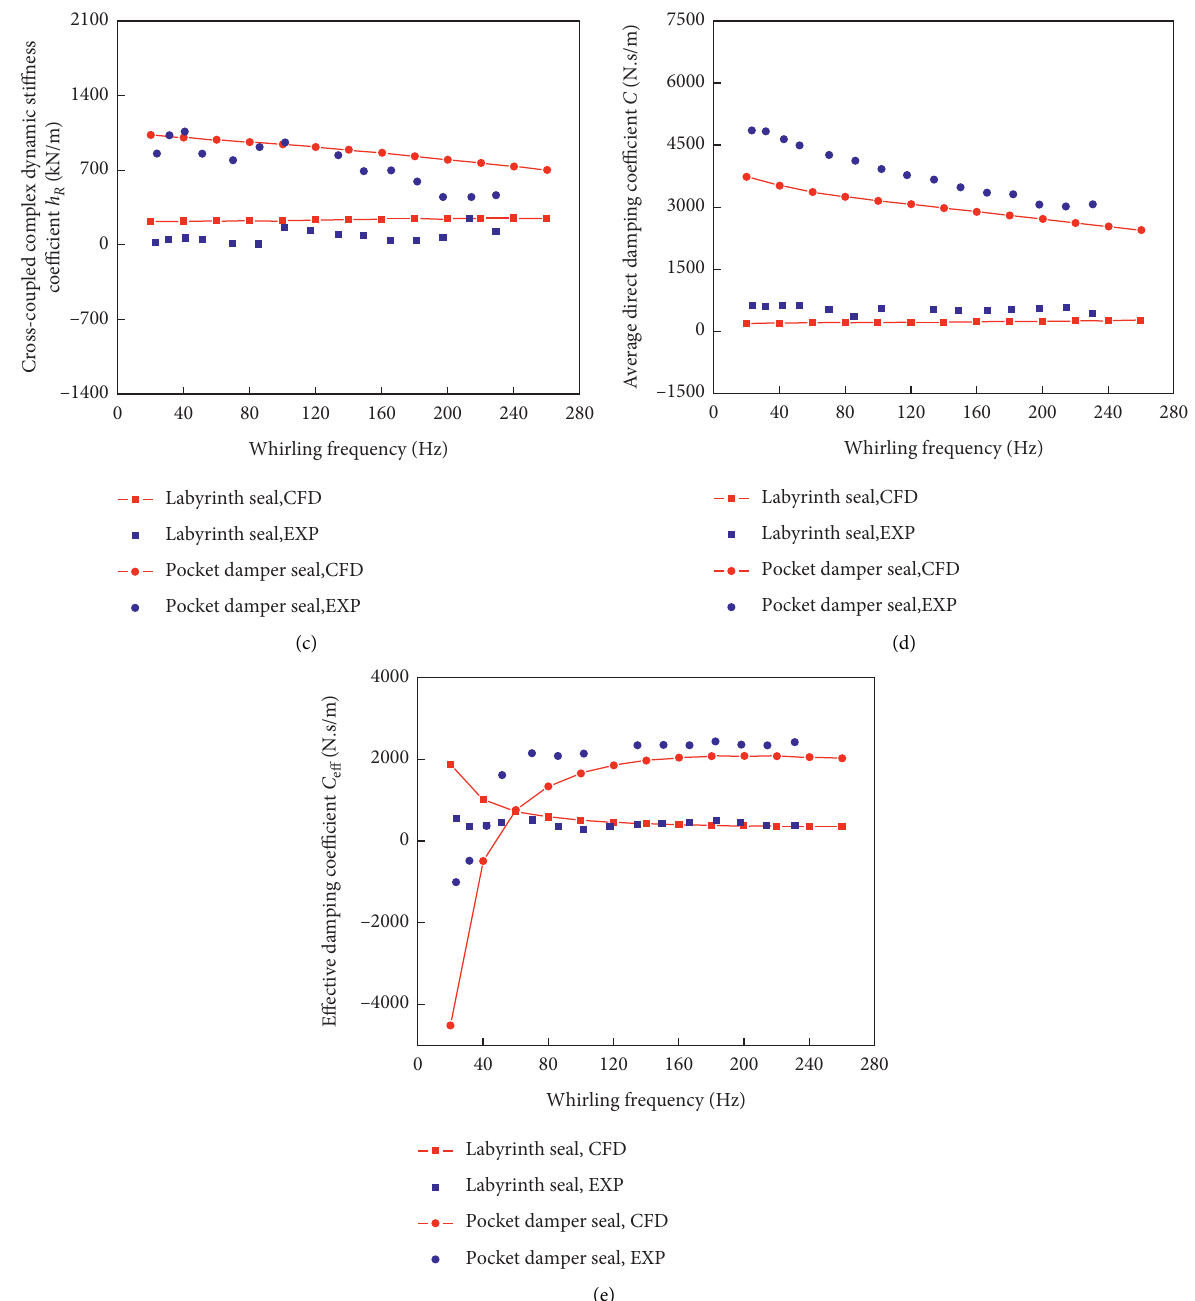
Figure 6: Comparison of experiments and current CFD results. (a) Leakage flow rate. (b) Direct complex dynamic stiffness coefficient. (c) Cross-coupled complex dynamic stiffness coefficient. (d) Average direct damping coefficient. (e) Effective damping